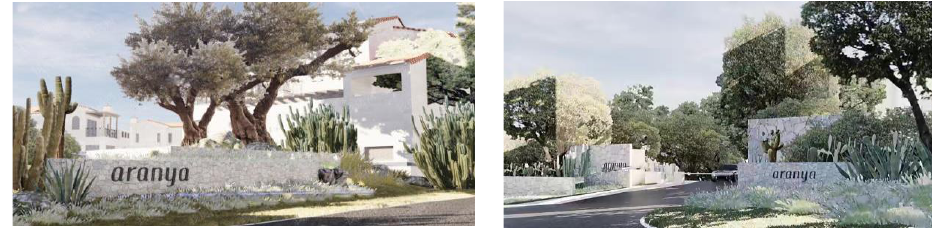
Figure 5. Sanya Anaya Entrance .